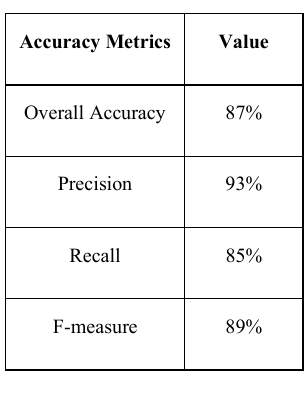
Figure 4. Potential Habitat Distribution of Water Hyacinth in Table 1. Accuracy Assessment of current distribution model